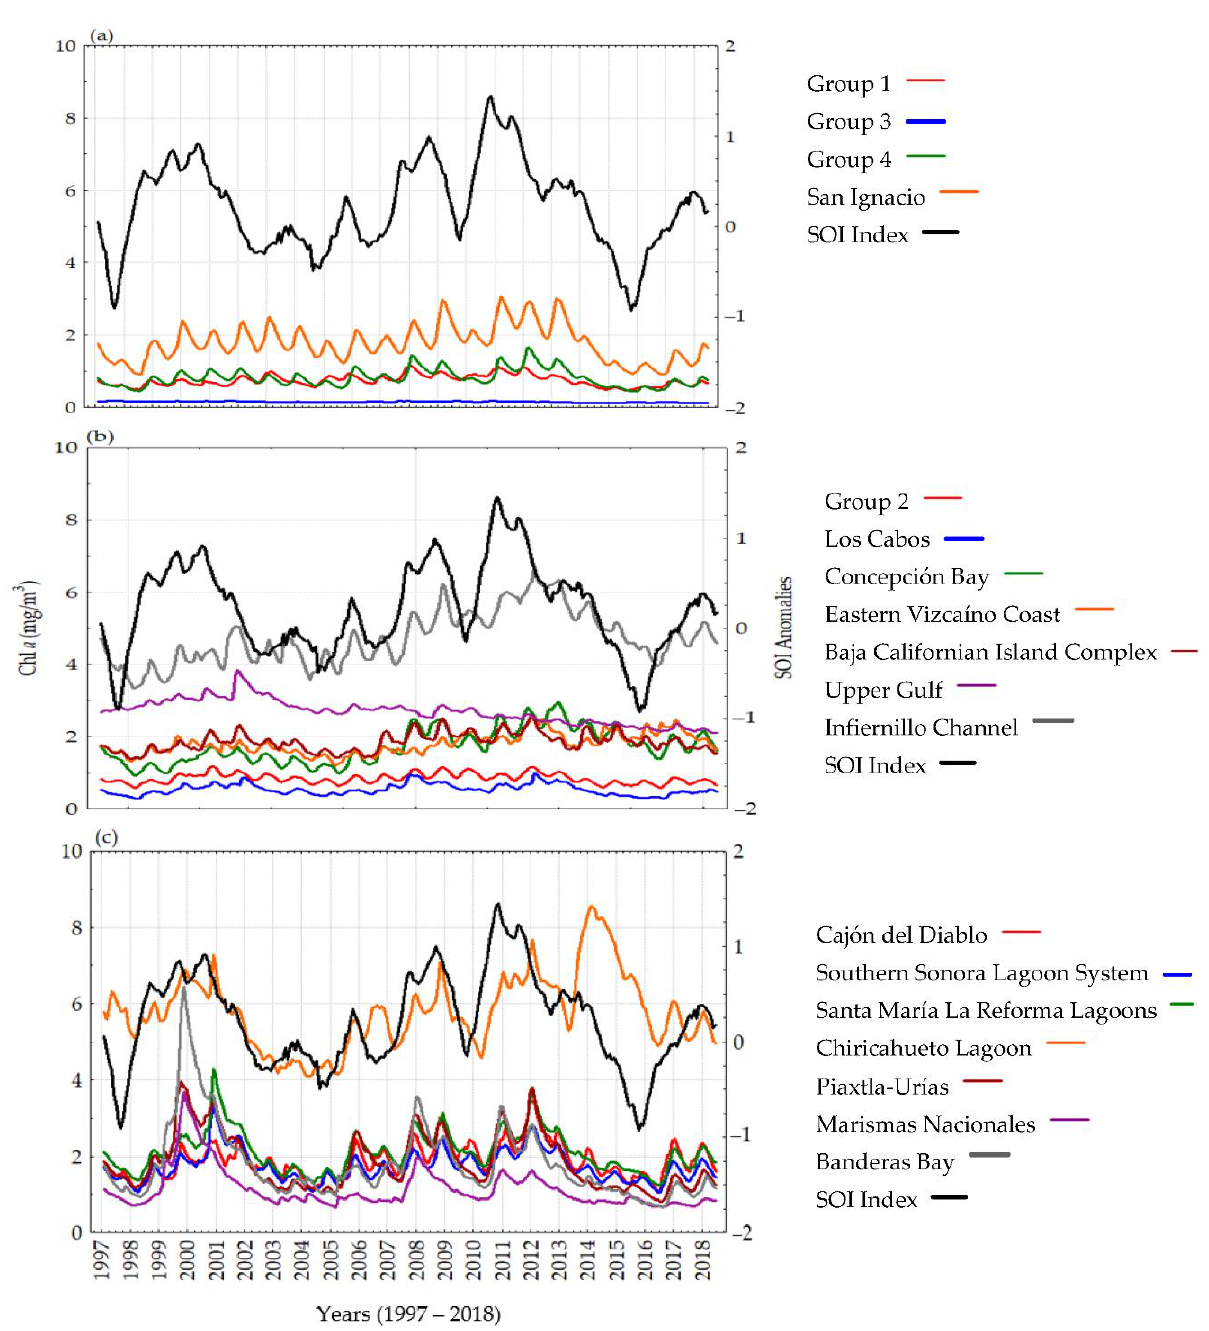
Figure 4. Time series of Chlorophyll a (Chl a ) concentration for the regions of the northwest of Mexico. South Californian Pacific ( a ); Gulf of California ( b , c ).